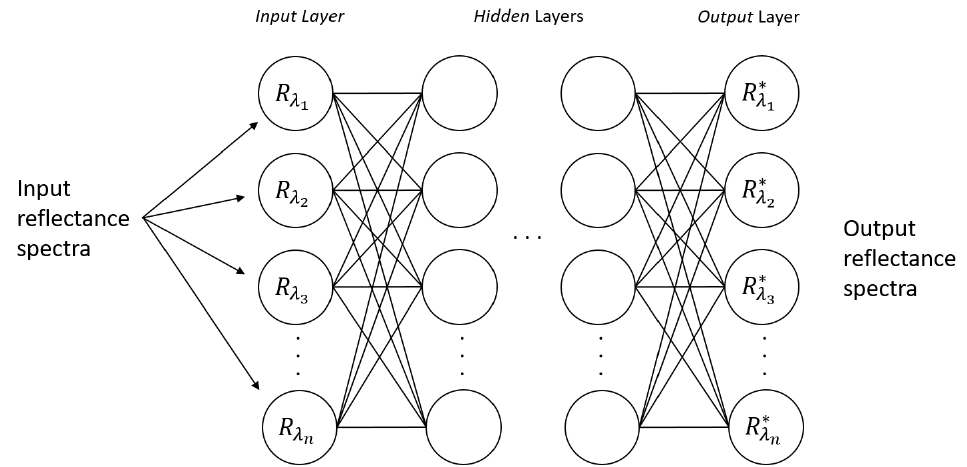
Figure 6. Multi-Layer Perceptron model for the correction of substrate spectral